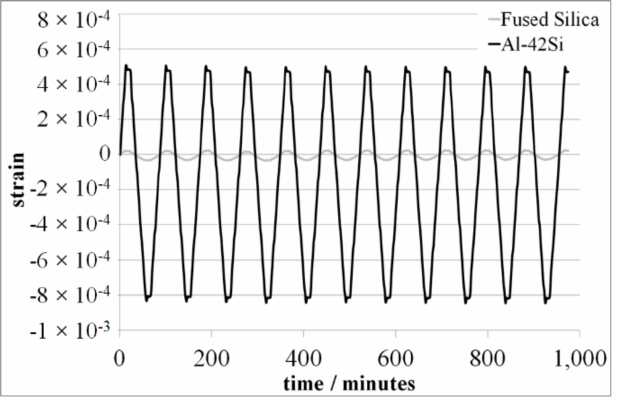
Figure 4. Strain behavior of Fused Silica and Al-42Si in a temperature range between − 40 ◦ C and 60 ◦ C.